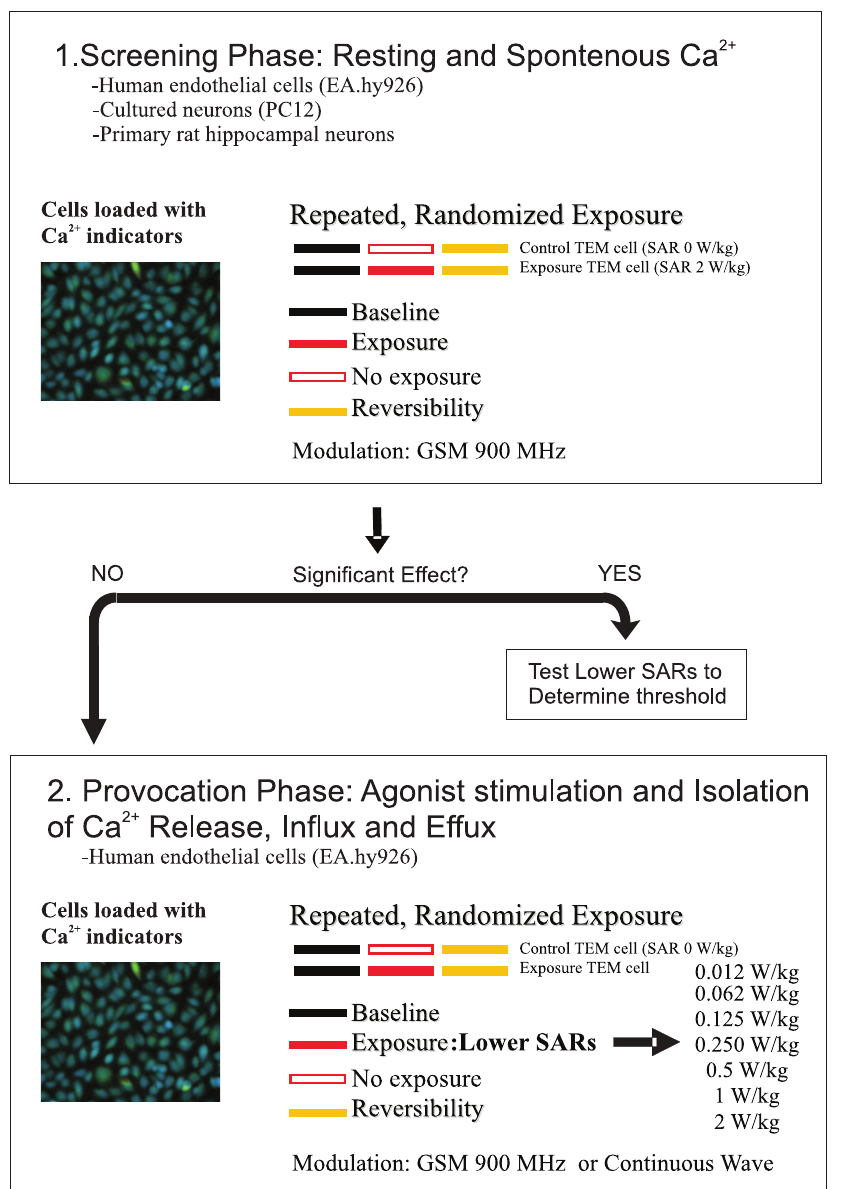
Figure 3. Experimental Flow Chart for Screening RF-Induced Ca 2 + Effects. The experimental work plan for Ca 2 + experiments consisted of a Screening Phase (1) and Provocation Phase (2). A screening phase was used to expose all cell types tested to a 2 W/kg 900 MHz GSM field for 30 minutes. If significant changes in Ca 2 + were observed in the exposure period, additional experiments would be performed at lower SARs to determine the threshold for the effect. If, however, no significant effects were observed in the screening phase, provocation experiments would